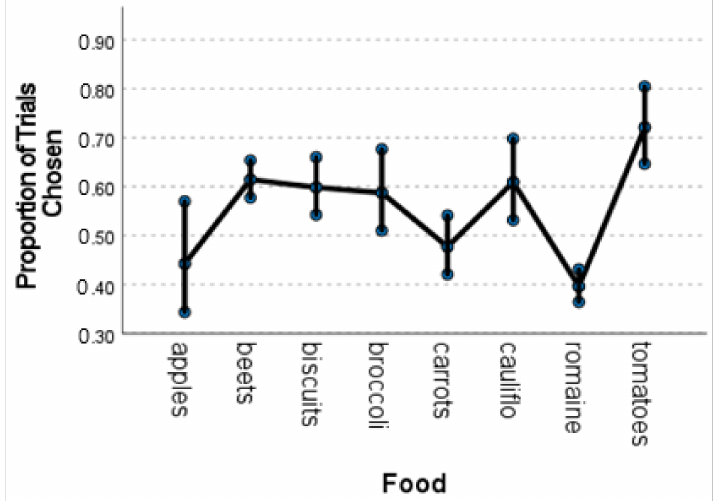
Figure 4. Estimated mean proportion of trials in which foods were chosen by all gorillas using the touchscreen. Error bars depict the standard error of the